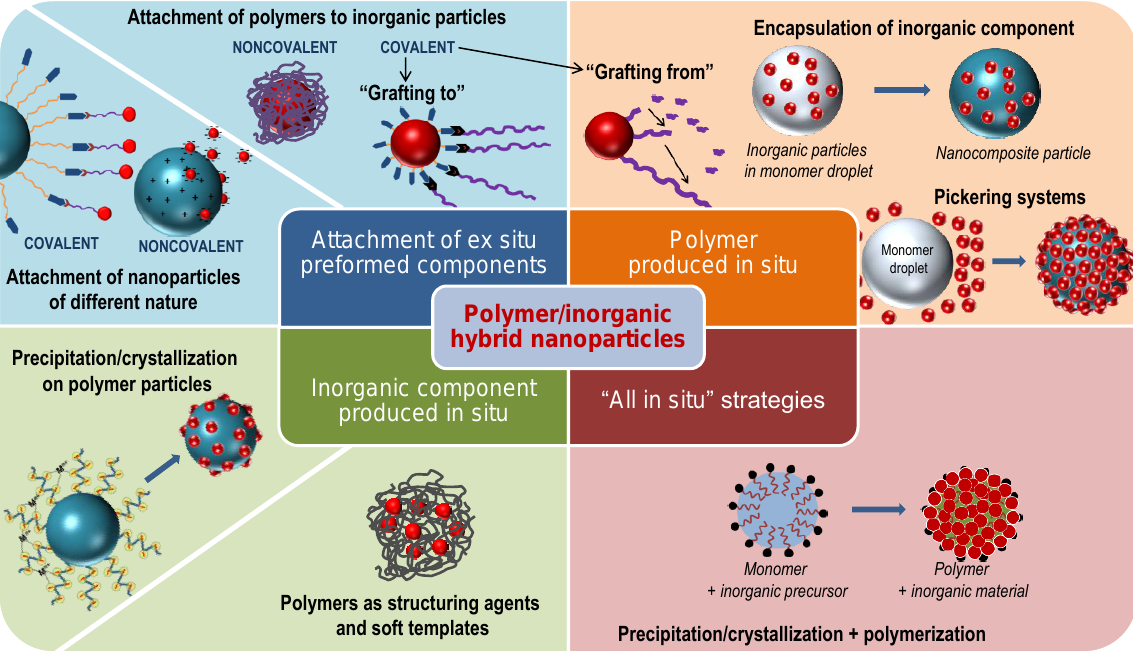
Figure 1. Different synthetic strategies in the formation of polymer/inorganic hybrid particles.